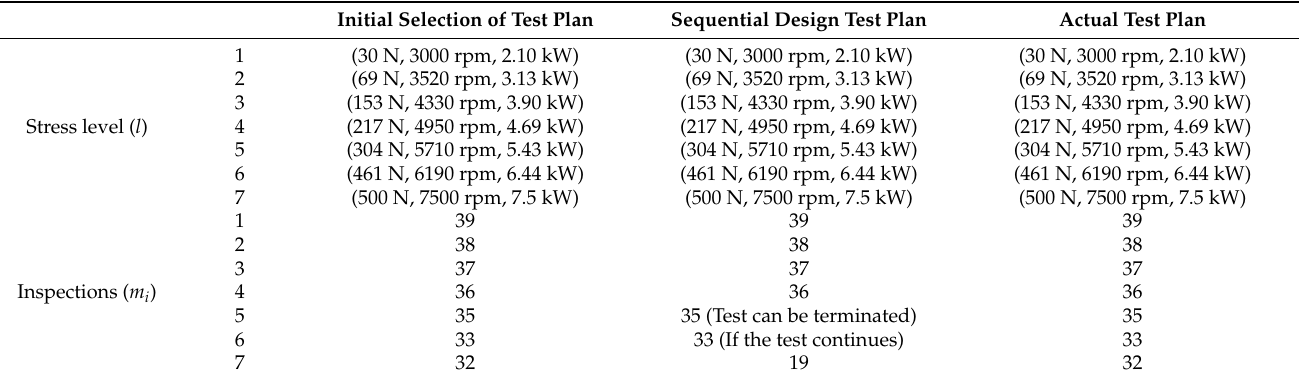
Table 11. The complete process of motorized spindle ADT.